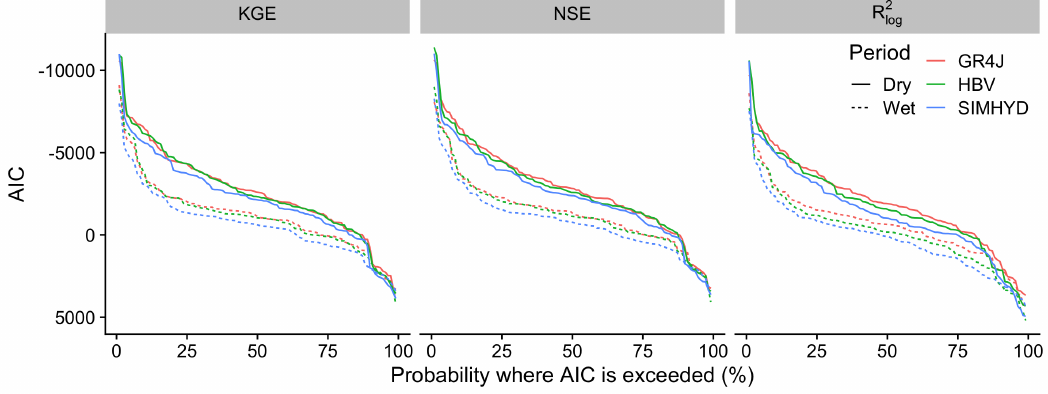
Figure 3. Comparing probability of exceeding a specific objective function value across the catchments standardised using the Akaike Information Criterion (AIC). Objective functions are in different panels and the models used for calibration are in different colours. The dry period is a solid line and the wet period is a dashed